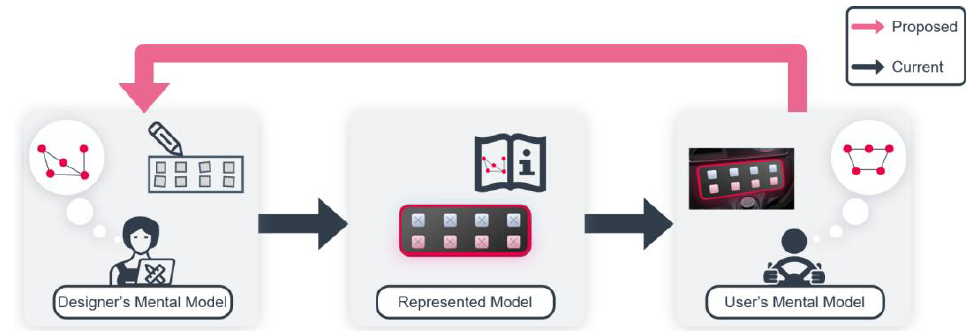
Figure 3. Flow of mental models based on Norman [46] with differentiating MMs between the user and designer represented by a divergent graphical representation, augmented by the proposed step to give the designer access to knowledge about the user’s initial MM of the system .